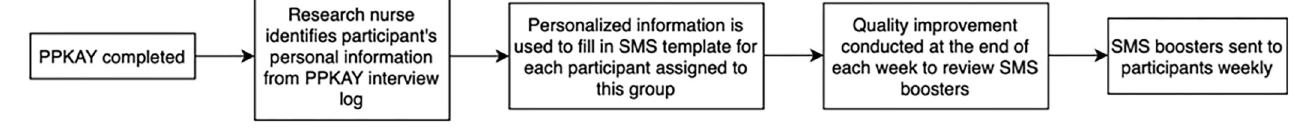
Fig 2. Workflow diagram for the creation of personalized SMS